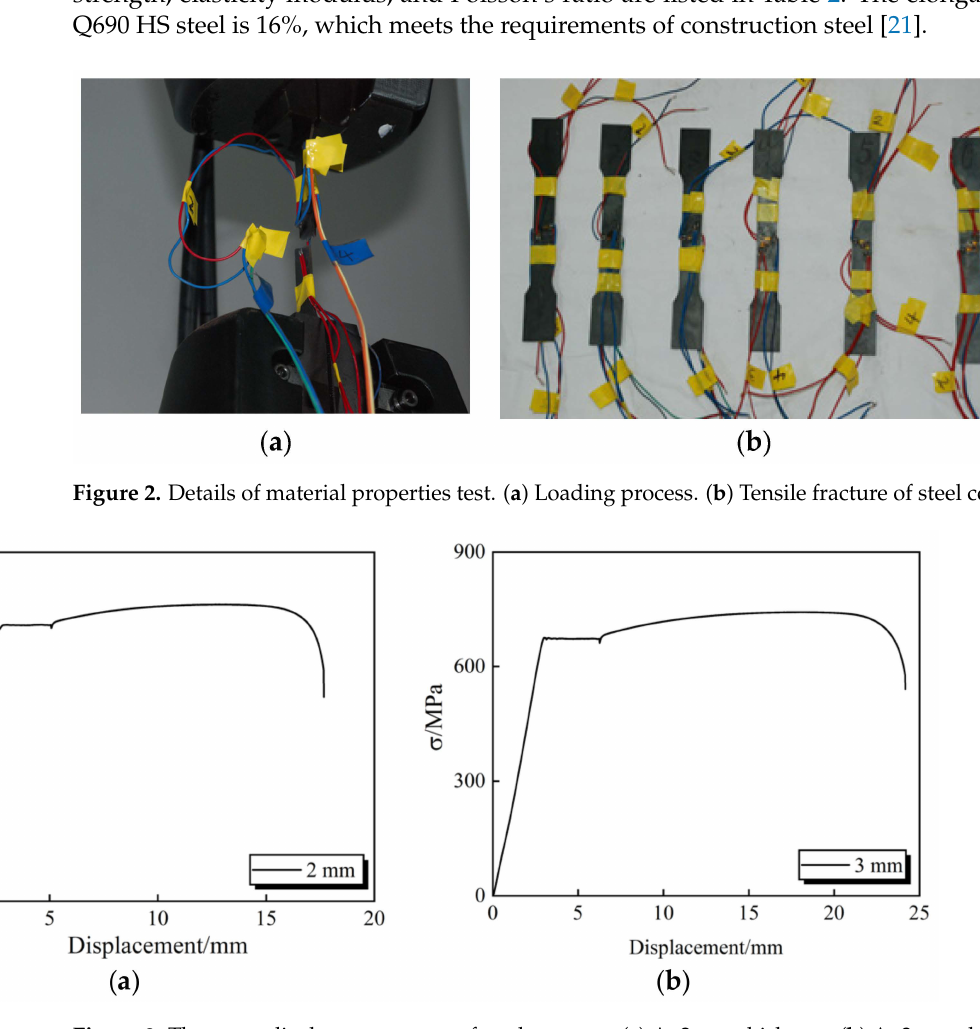
Figure 3. The stress-displacement curve of steel coupons. ( a ) At 2 mm thickness. ( b ) At 3 mm thickness. Table 2. Test results of steel